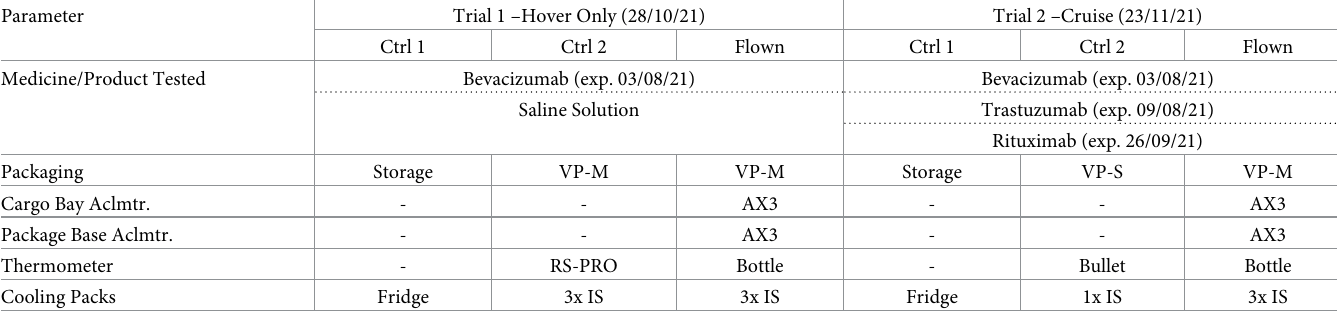
Table 1. Packaging and sensor arrangements for each